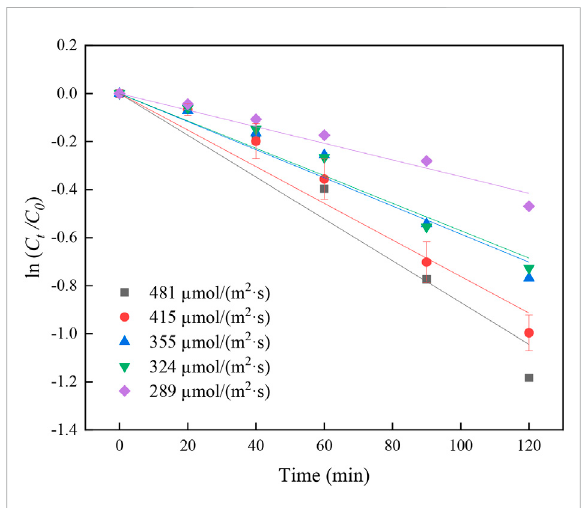
FIGURE 5 Effect of solution pH on photodegradation of acid orange 8 by NCM.